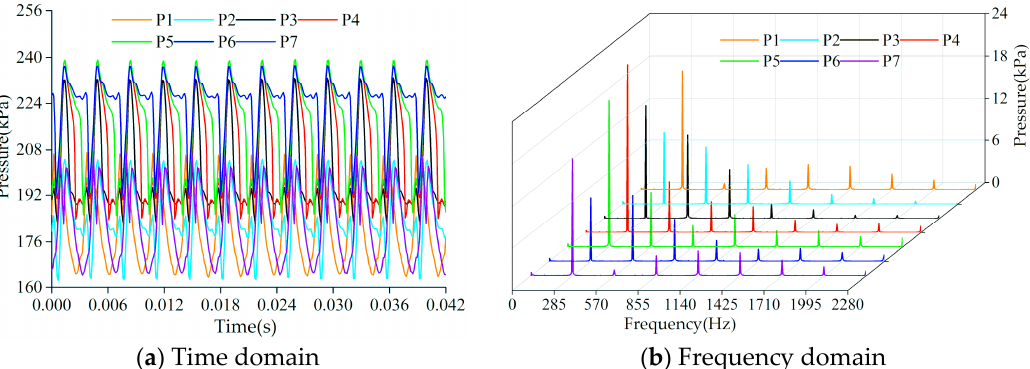
Figure 19. The time and frequency domain diagrams of pressure fluctuation for monitoring points at the inlet edge of a guide vane channel.